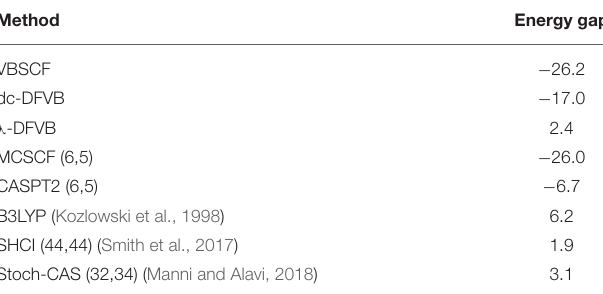
TABLE 5 | The triplet–quintuplet energy gap of Fe(II)–porphyrin by various methods (in kcal/mol).